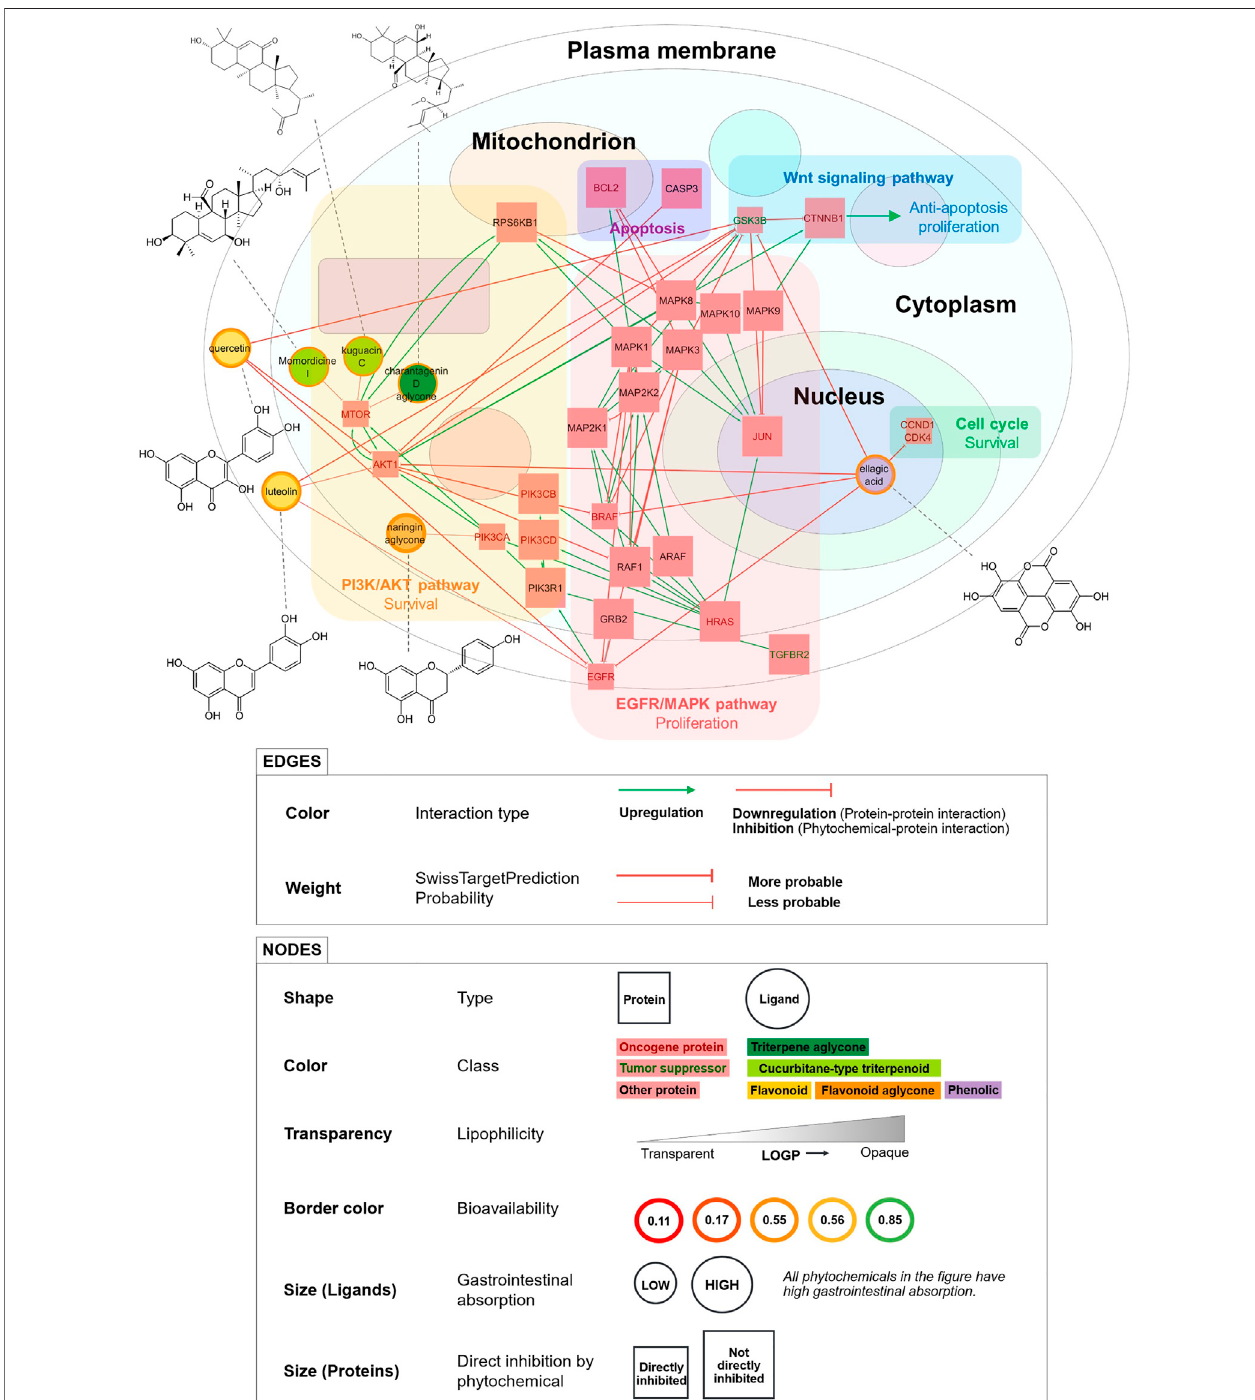
FIGURE 4 | Simpli fi ed PCPI network showing the predicted anticancer action of bitter gourd (with high docking con fi dence and probability (cid:1) 1 PCPIs from docking). Pathways and downstream effects are shown. Phytochemical structures are connected to their corresponding nodes by dashed lines. All PCPIs are represented by red arrows indicating inhibition. Smaller square nodes are proteins directly inhibited by phytochemicals in the network.